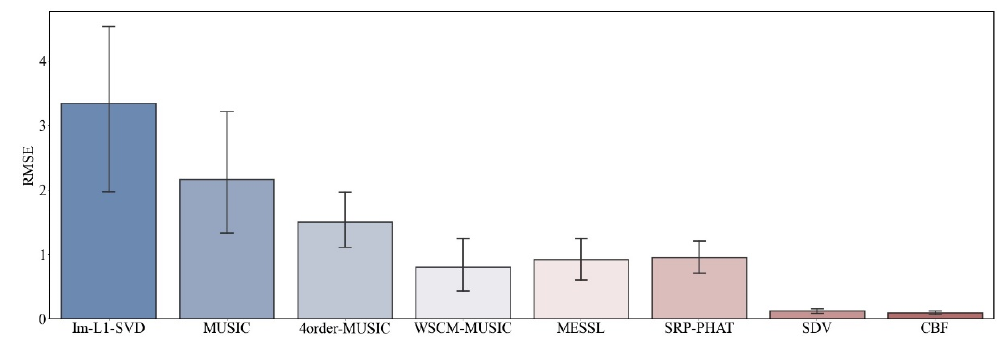
Figure 9. RMSE of direction estimation with SNR 1 = − 10 dB. Table 2. Comparison of different beamforming methods with input SNR = − 27 dB and targetdirection = 33 ◦